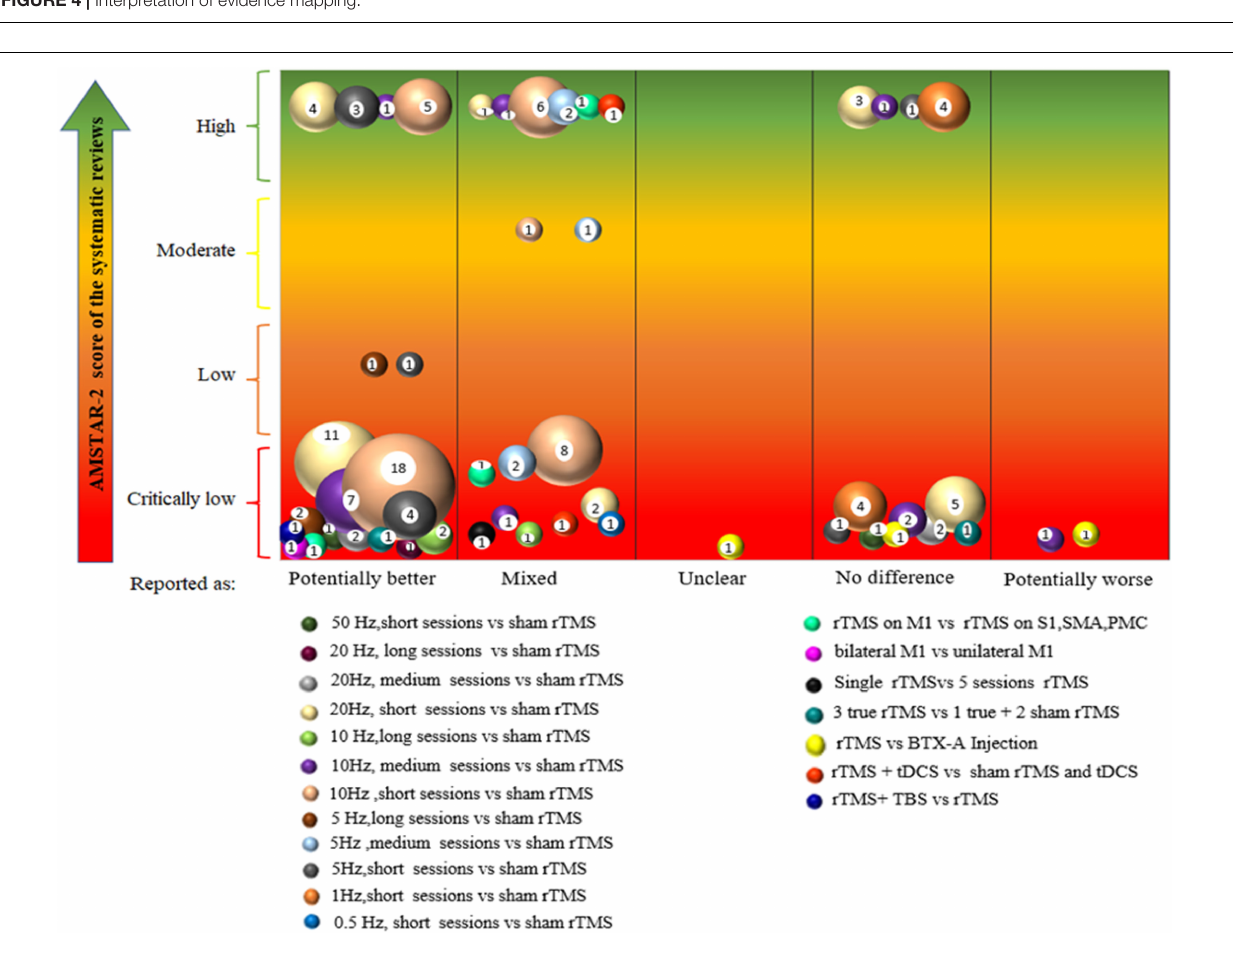
FIGURE 4 | Interpretation of evidence mapping.